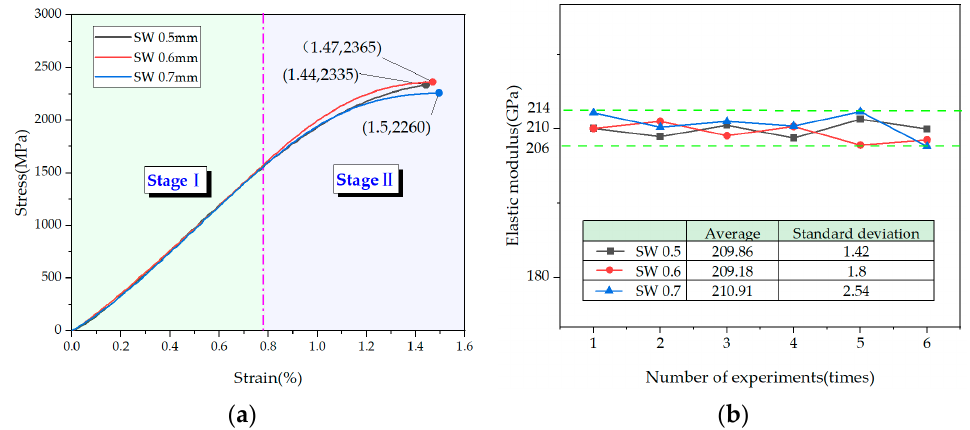
Figure 6. Tension of cold-drawn non-alloy steel wire for springs: ( a ) stress–strain curves of cold- drawn non-alloy steel wire for springs with different diameters.; ( b ) analysis of elastic modulus of steel wire.